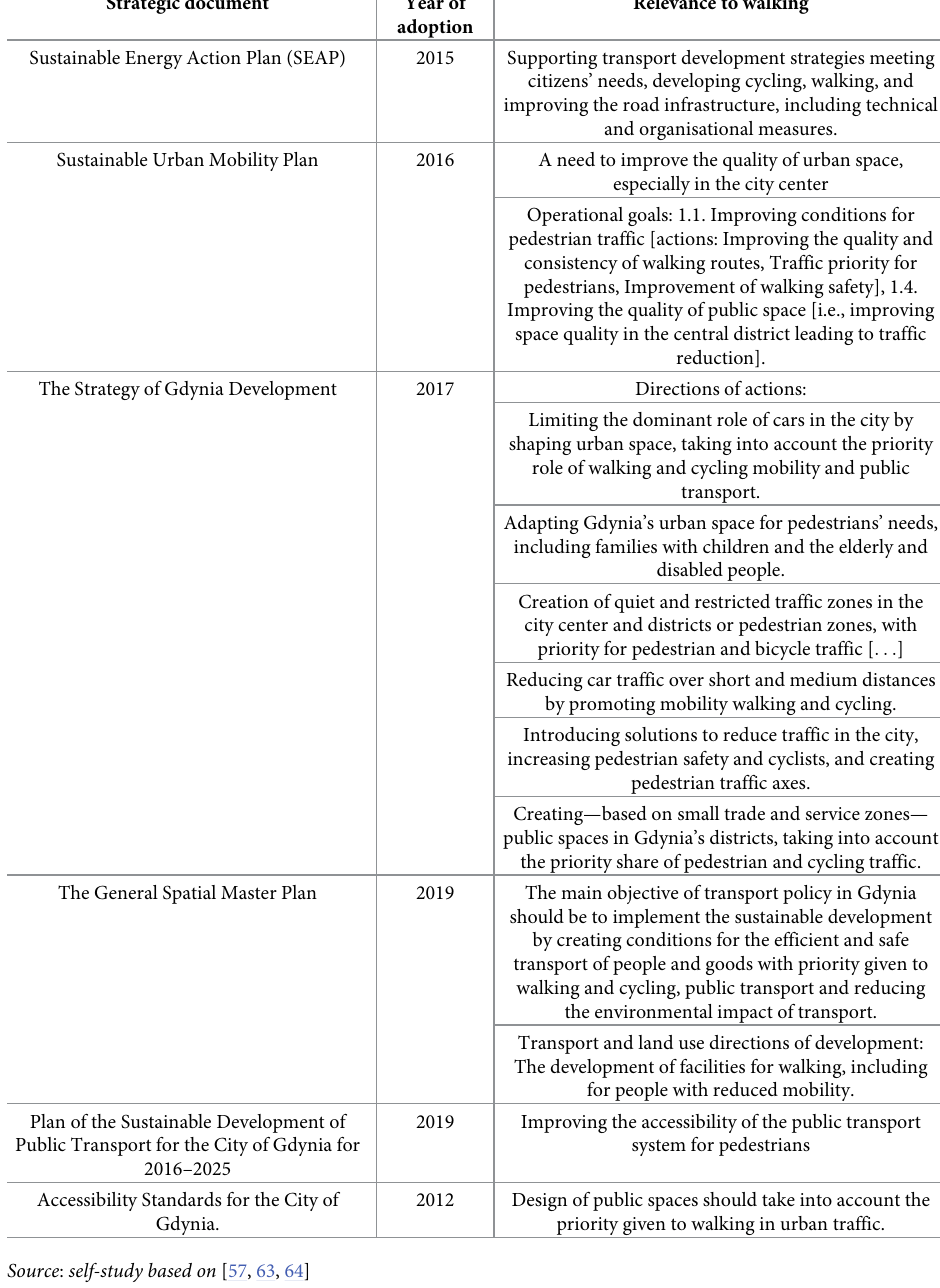
Table 2. Walking in the strategic documents of the city of